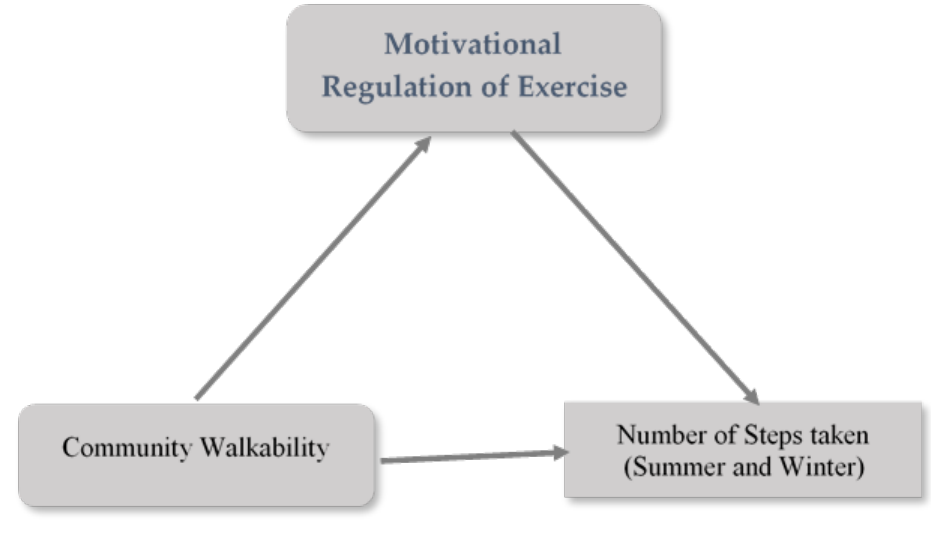
Figure 1. Research model.